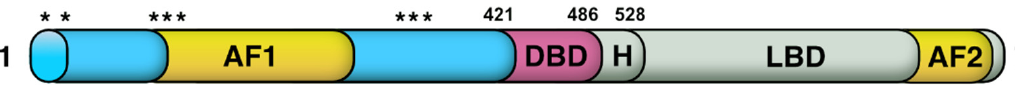
Figure 1. Glucocorticoid receptor domain structure and translational isoforms. The N-terminal domain (NTD), which is required for ligand-independent gene transactivation, includes a transcriptional activation function region (AF1). The latter, which interacts with coregulators and with the basal transcriptional machinery, is the main posttranslational modifications site. The LBD, which is made up of 12 α -helices and 4 β -sheets, forms a hydrophobic pocket needed for GC binding and includes an AF2 domain. The latter allows interaction with coregulators in a ligand-dependent way. Finally, two nuclear localization signals, named NL1 and NL2, are localized in the DBD-hinge region junction and within the LBD, respectively. Asterisks indicate the location of the starting amino acid (aa position: 1, 27, 86, 90, 98, 316, 331, 336) of the eight different GR α translational isoforms, which are characterised by progressively shorter NTDs.